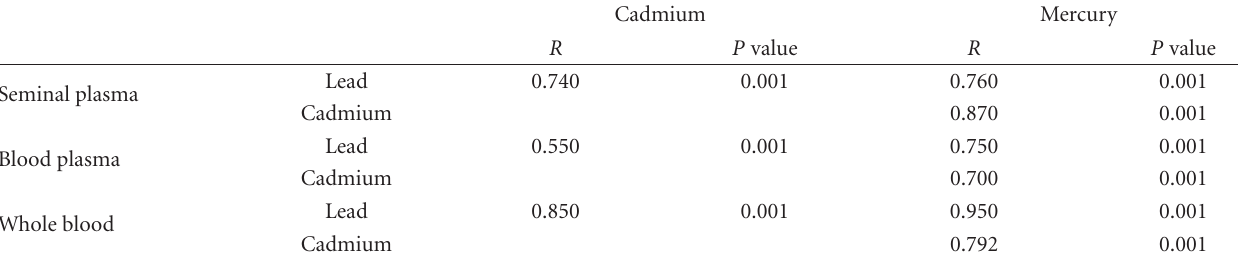
Table 5: Spermean’s correlation coe ffi cients between seminal plasma, blood plasma, and whole blood, with metal concentrations.